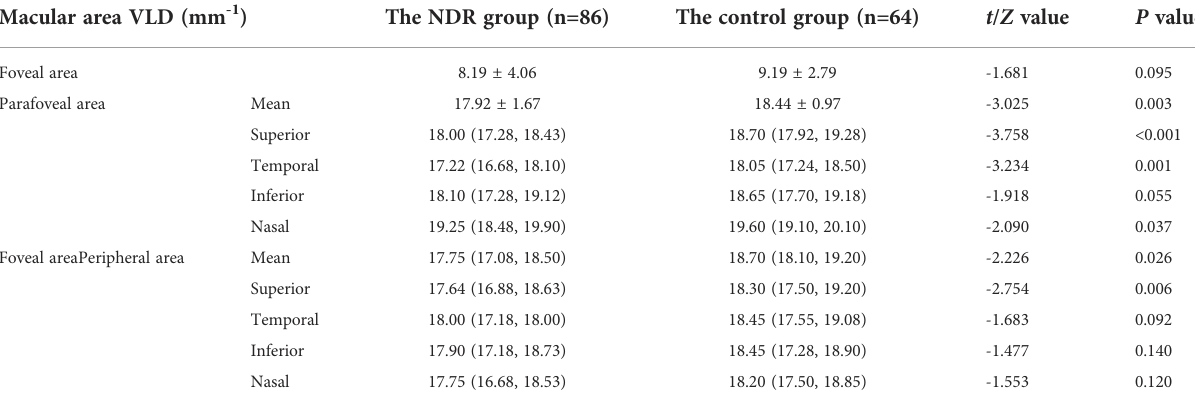
Normally distributed measurement data are represented by x ± s, and independent sample t-test was used for the comparison between the two groups. Non-normally distributed measurement data are represented by M (P25, P75), and the Mann-Whitney U test was used for the comparison between the two groups. NDR, Diabetes mellitus without diabetic retinopathy; VLD, vessel length